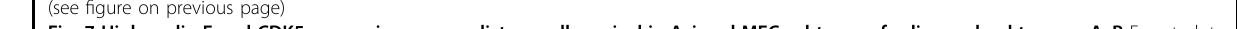
Fig. 7 High cyclin E and CDK5 expression can predict overall survival in Aci and MEC subtypes of salivary gland tumors. A , B Forest plots analysis indicating univariable analysis of the indicated variables with overall survival in each Aci and MEC subtypes. The solid gray line indicates a hazard ratio of 1 for the overall population. Variables with p values < 0.05 are marked with * and are signi fi cant predictors of recurrence-free survival for each subtype, calculated using the Cox proportional-hazards model. C , D Kaplan – Meier plots for subtypes Aci and MEC respectively, according to LMW-E, CDK5, or LMW-E/CDK5 expression. The expression of LMW-E and CDK5, individually and combined, was signi fi cantly associated with decreased overall survival in the indicated subtypes. p Values indicate comparison between survival curves, calculated using the log-rank (Mantel – Cox) test. E , F Graph comparing median OS without any biomarkers (black bars) to that when patient tumor samples are positive ( H -score = 1) for LMW-E (blue bars), CDK5 (pink bars), or LMW-E /CDK5 (yellow bars); for each subtypes Aci and